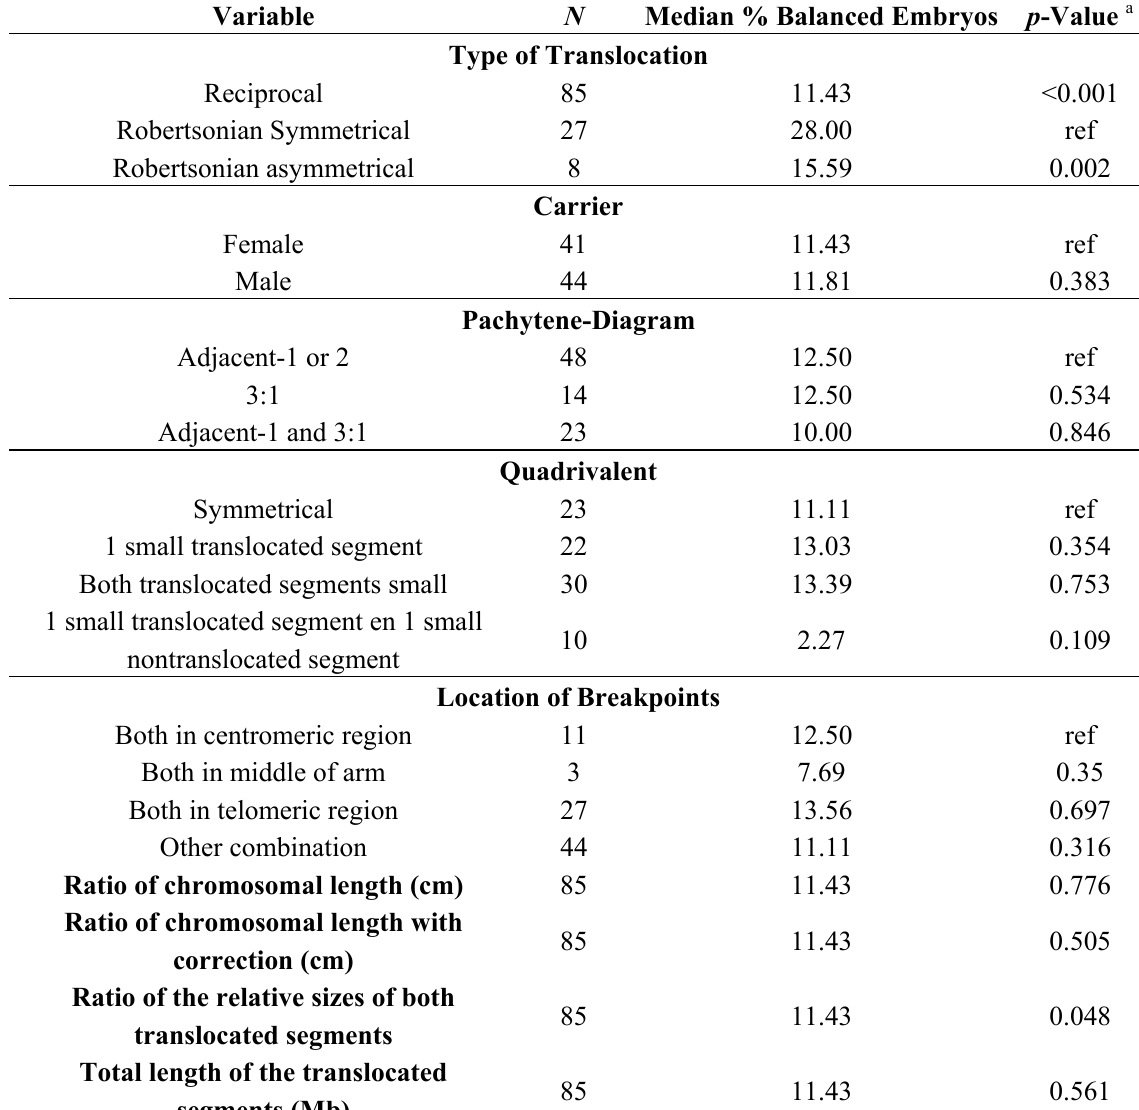
Table 3. Univariate linear regression analysis for 85 reciprocal translocation carriers, regarding the percentage of balanced embryos in PGD